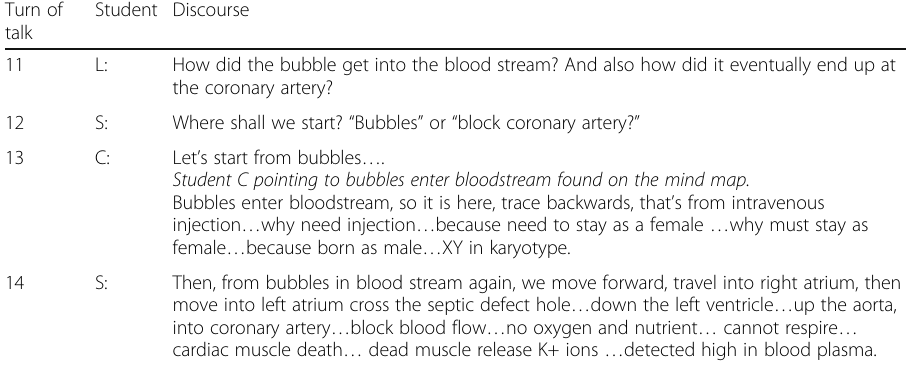
Table 8 Excerpt 2: A segment of discourse from group F ’ s discussion (lines 11 to 14) Turn of